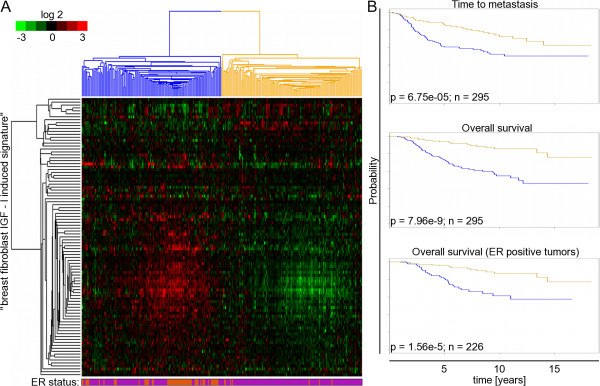
Breast fibroblast derived IGF-I signature in early stage breast cancer. (A) Unsupervised hierarchical clustering of breast fibroblast derived IGF-I signature in Netherlands Cancer institute dataset. The expression values of genes in the breast fibroblast derived IGF-I signature revealed by signficant analysis of microarray were extracted from a published expression study of 295 early stage breast cancers from the Netherlands Cancer Institute (NKI). Genes are presented in rows and experiments in columns. Breast fibroblast derived IGF-I signature stratifies early breast cancer patients (NKI) into two groups with high (blue) or low (yellow) expression levels of genes representing the signature. Horizontal bar below the figure represents positive (purple) or negative (orange) ER status. (B) Relationship of expression level of genes building breast fibroblast derived IGF-I signature with distant metastasis free and overall survival. Kaplan-Meier curves representing the clinical outcomes of tumors exhibiting high (blue curve) and low (yellow curve) expression levels of the IGF-I induced signature. The upper two figures represent all patients and the bottom figure shows only patients with oestrogen receptor positive breast tumours.